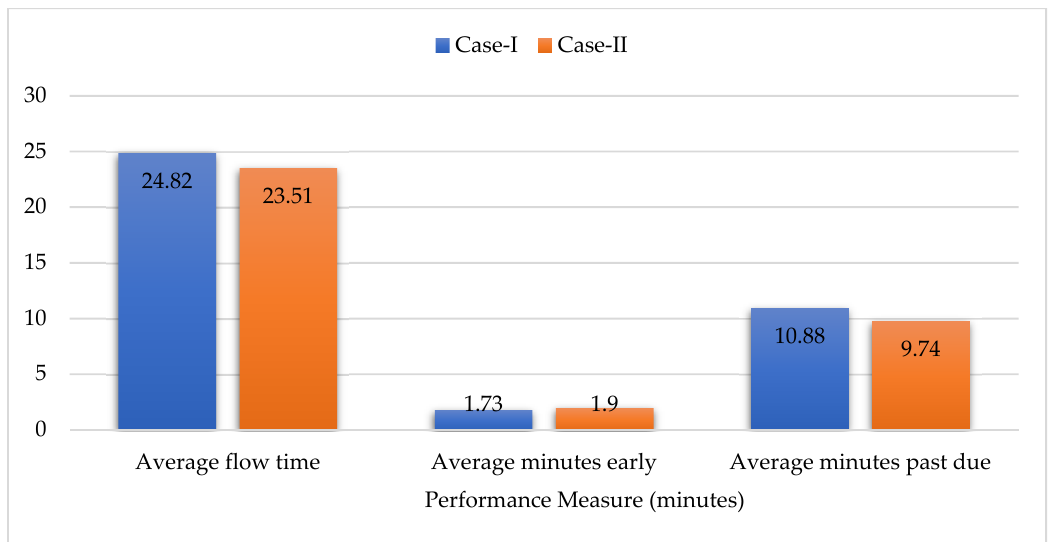
Figure 8. Comparison of the performance measures for Case-I and Case-II using the SPT rule.